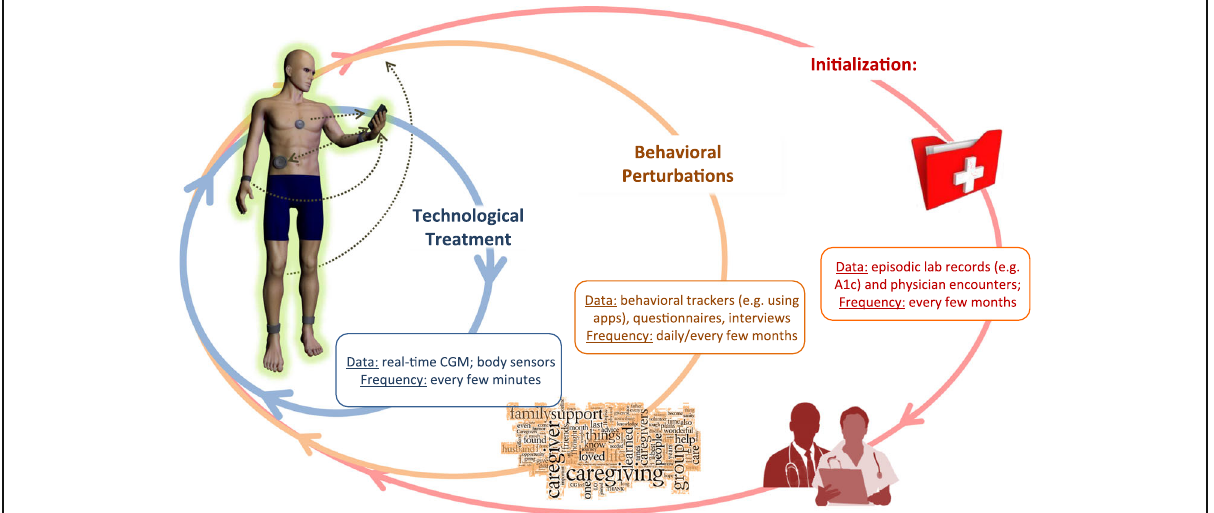
Fig. 1 The Treatment Ecosystem of diabetes – a combination of superimposed interacting processes developing at different time